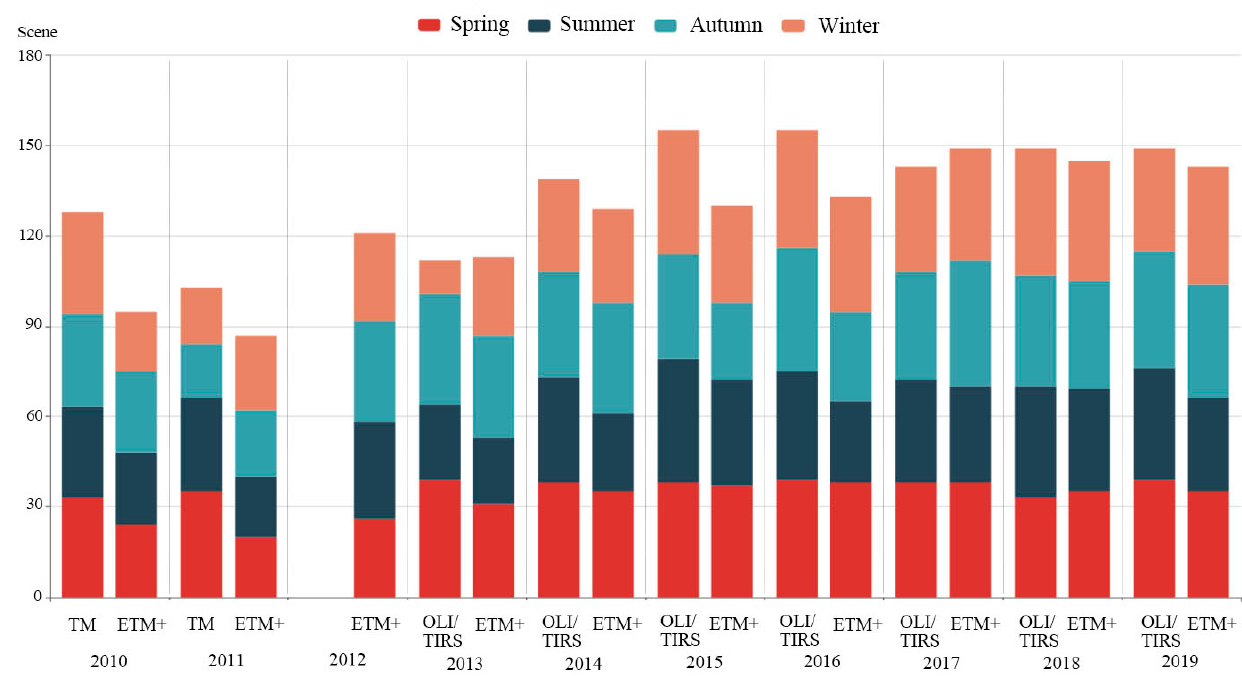
Figure 2. Number of available Landsat data by sensor, year and season.